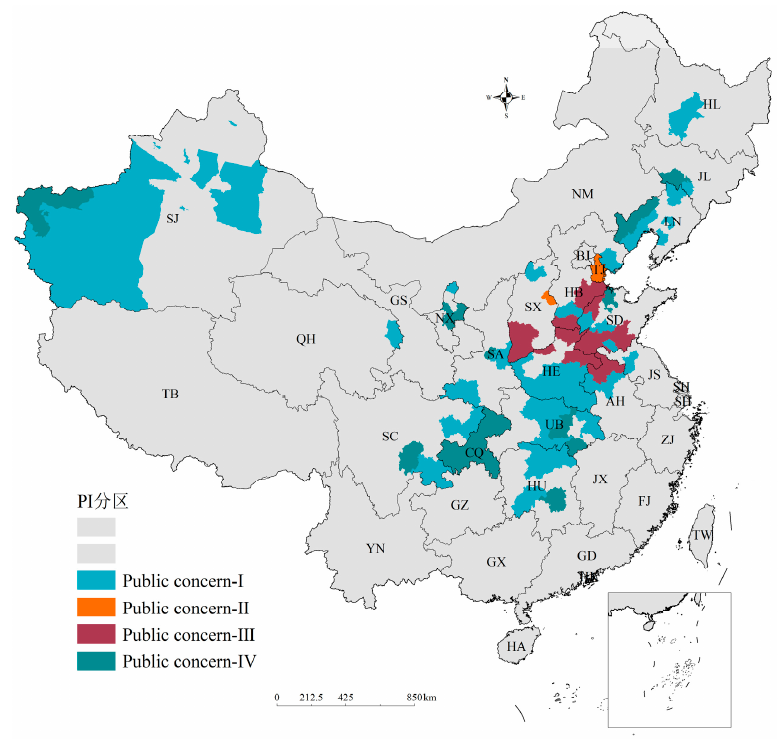
Figure 5. Public concern zoning against the background of PM 2.5 and ozone joint prevention and control.